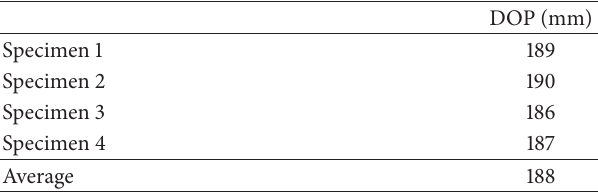
Table 2: Maximum depth of penetration of the projectile.